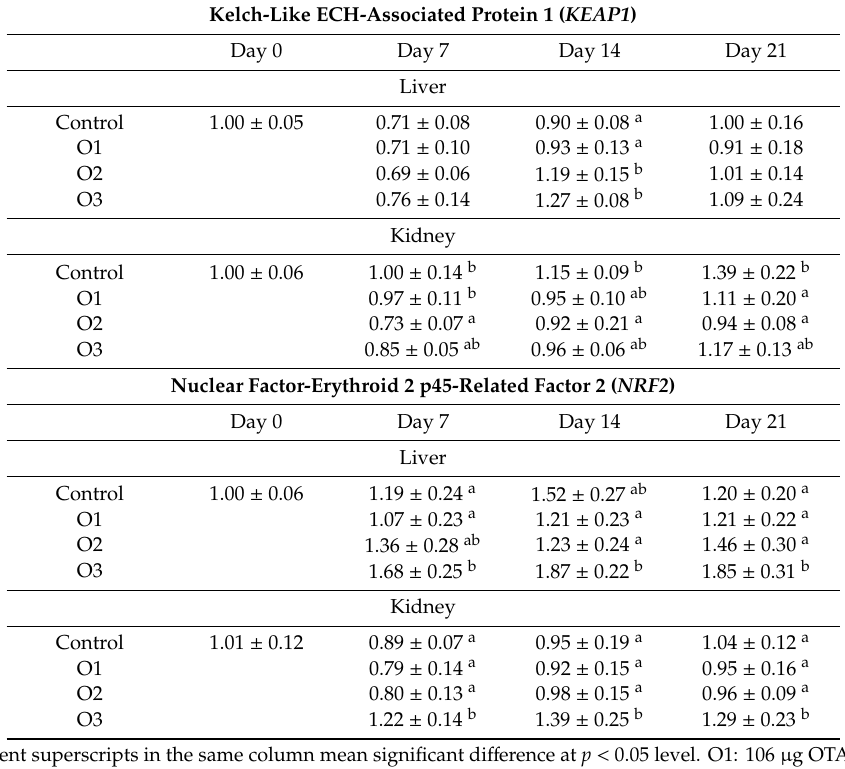
Table 7. E ff ect of Ochratoxin A treatment on the relative expression of KEAP1 , NRF2 genes in the liver and kidney of broiler chickens (mean ± SD; n = 6 in a pool, equal amounts of cDNA per individual). Kelch-Like ECH-Associated Protein 1 ( KEAP1